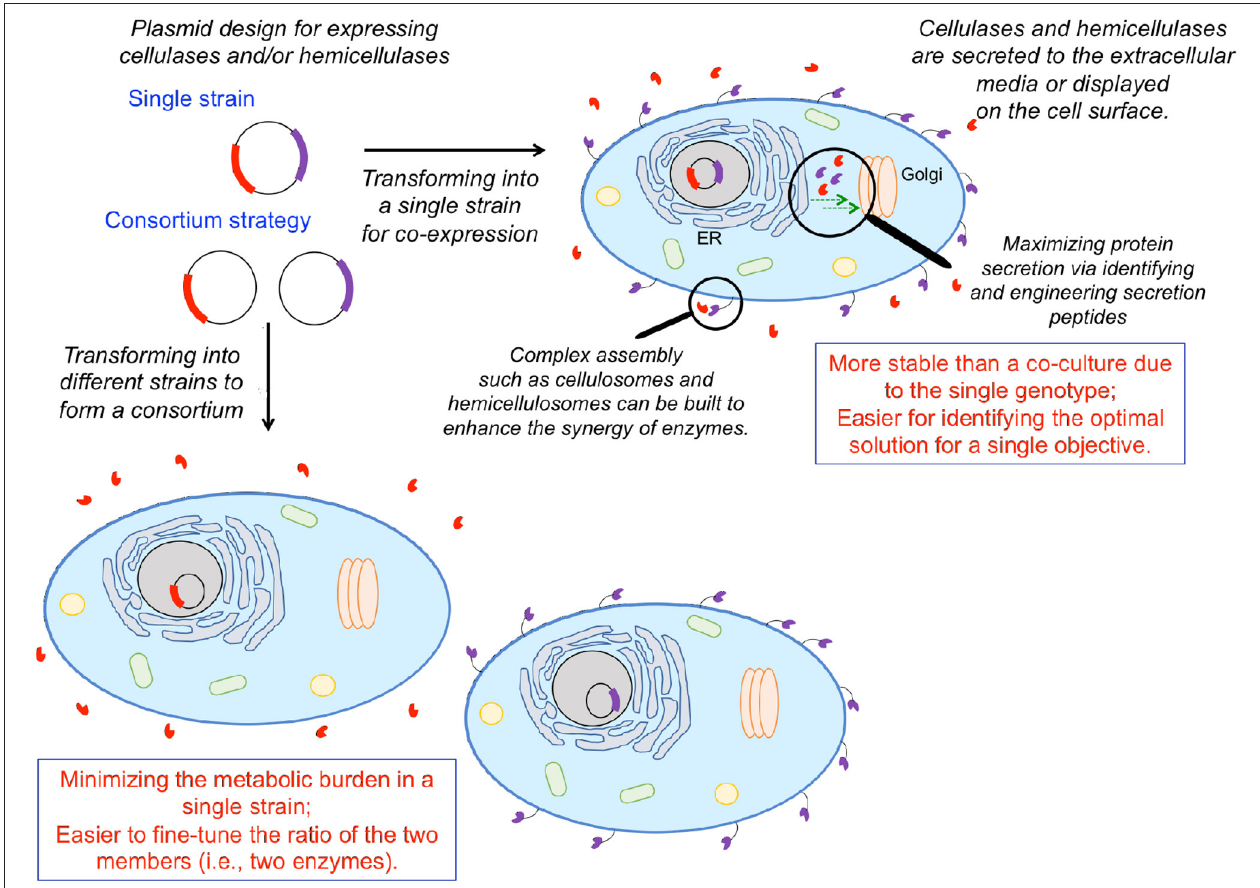
FIGURE 3 | Solubilizing biomass to fermentable sugar substrates for biochemical production via heterologous expression of cellulases and hemicellulases. One can either engineer a single organism to express multiple cellulolytic/hemicellulolytic enzymes or employ a consortium strategy, engineering multiple organisms to each express a single enzyme. Enzymes can either be expressed on the cell surface, or secreted to the extracellular medium, depending on the application. Heterologous protein expression can be enhanced via identifying/engineering secretion tags and facilitating transport either from the endoplasmic reticulum to the Golgi, or the Golgi to the cell surface. Individual enzymes can be brought into spatial proximity via assembly of complex structures mimicking cellulosomes and hemicellulosomes to coordinate enzymatic